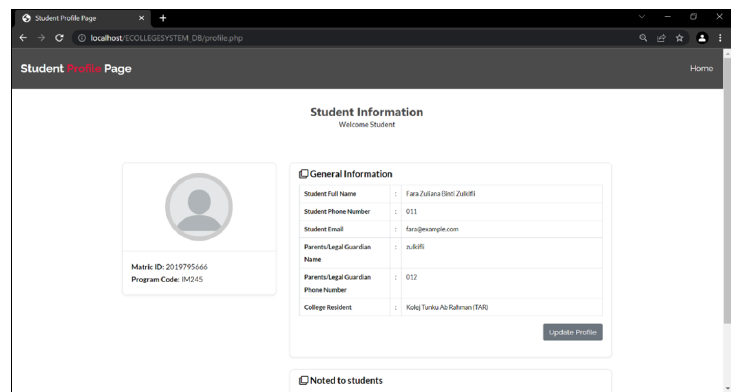
Figure 4. Students’ registration page.